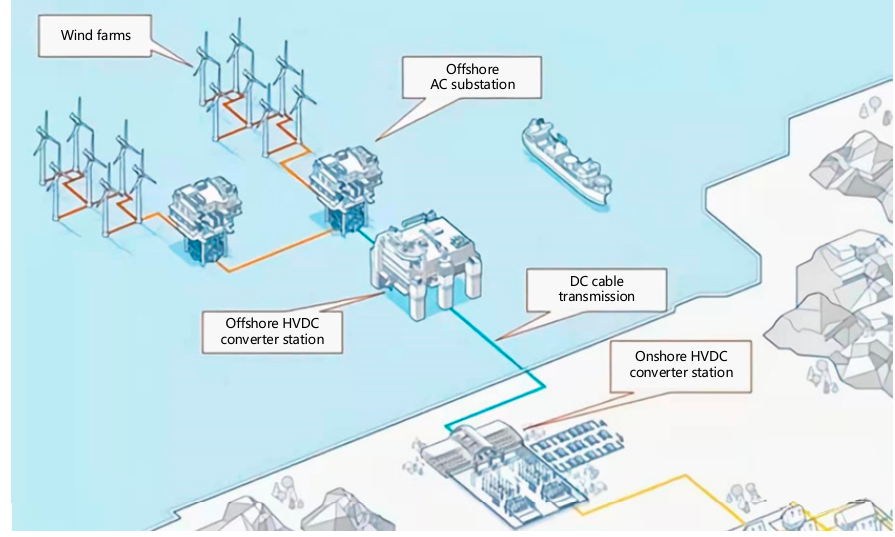
Figure 12. Centralized converter method for offshore wind power DC transmission